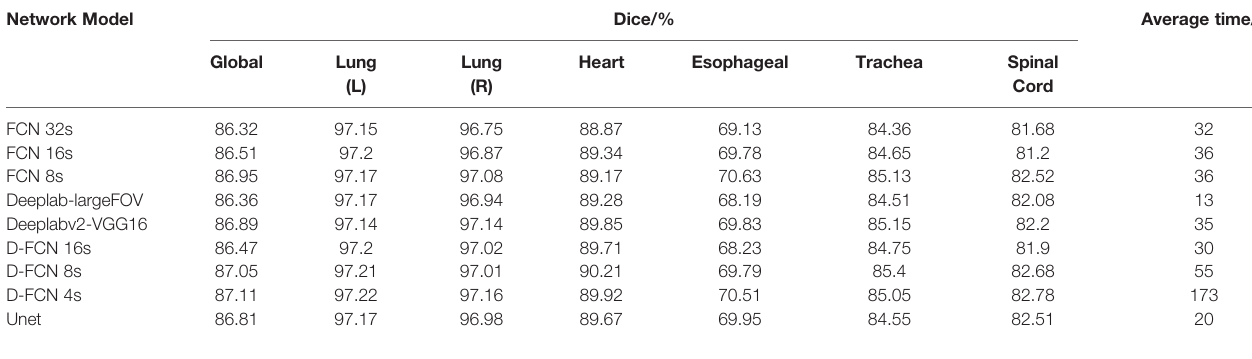
TABLE 2 | Test results of the optimal segmentation models of the 8 network models. Network Model